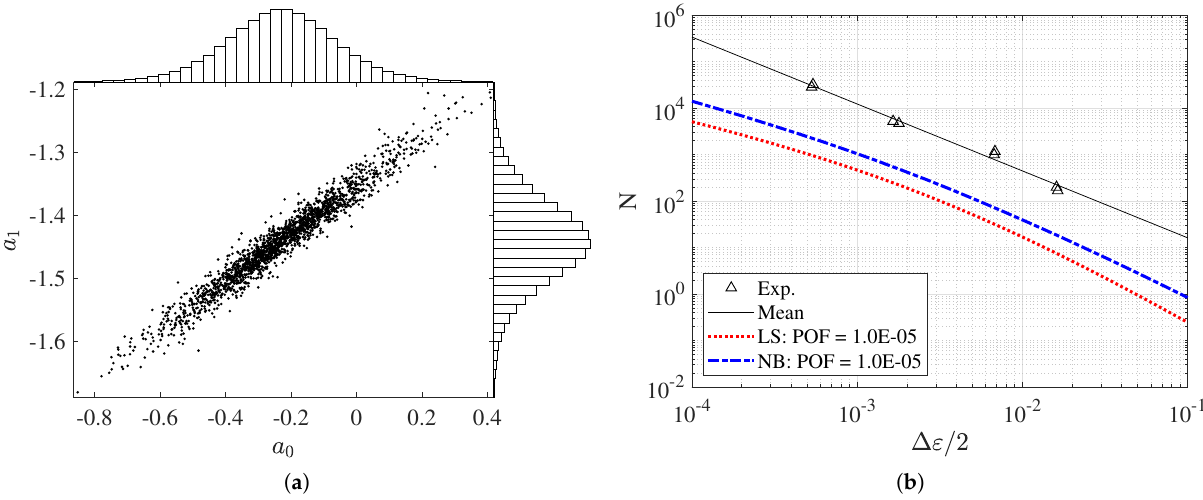
Figure 1. ( a ) MCMC samples drawn from the noninformative Bayesian posterior with Jeffreys’ prior ( q = 2) and ( b ) the fatigue life results at POF = 10 − 5 obtained with the regular least squares (LS) estimator and noninformative Bayesian